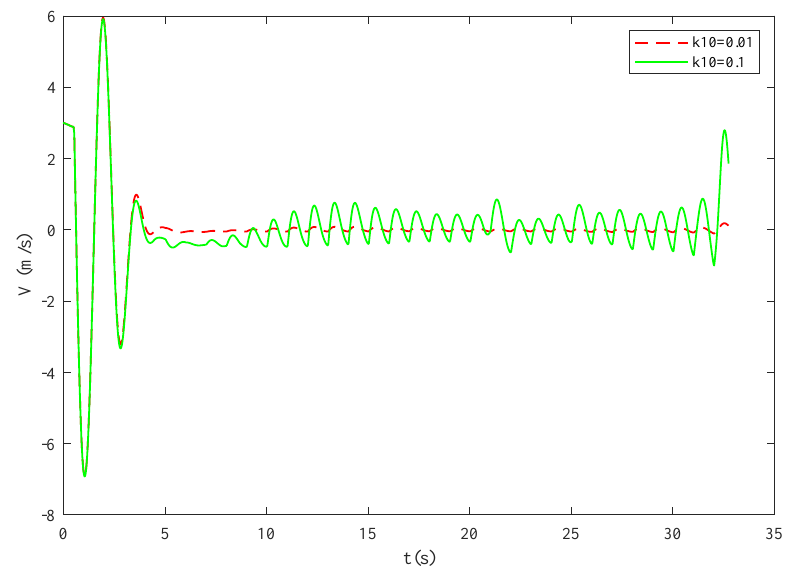
Figure 12. Change curve of roll angle rate under drifts error condition.